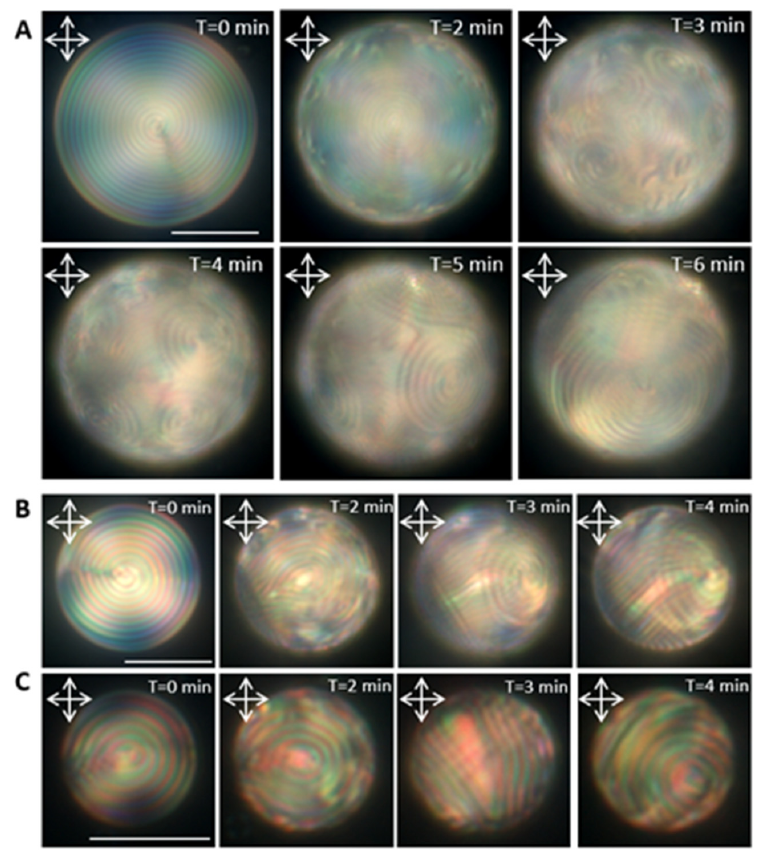
Figure 3. Reflection mode POM images of the reconfiguration dynamics of the low-chirality droplets of different sizes in the presence of 1 mM DLPC. ( A ) 50 µm, ( B ) 30 µm, and ( C ) 20 µm (scale bar = 20 µm).